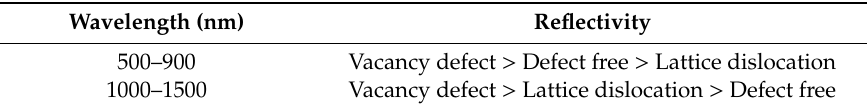
Table 3. Comparison of the reflectivity of three models Wavelength (nm)